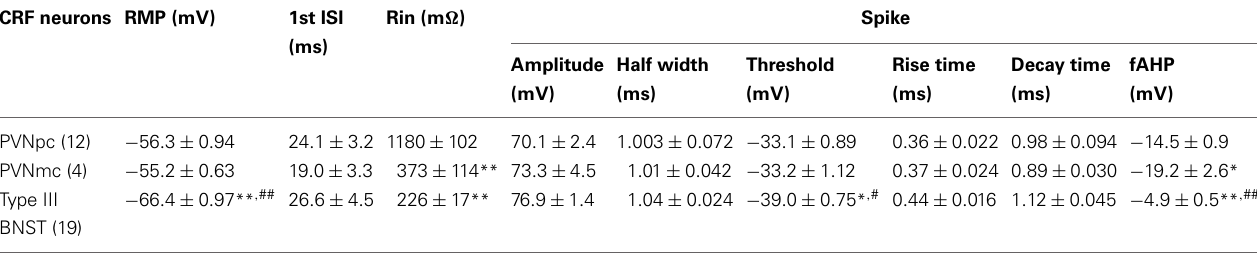
Table 2 | Distinct membrane properties of CRF neurons in the PVN and BNST ALG . CRF neurons RMP